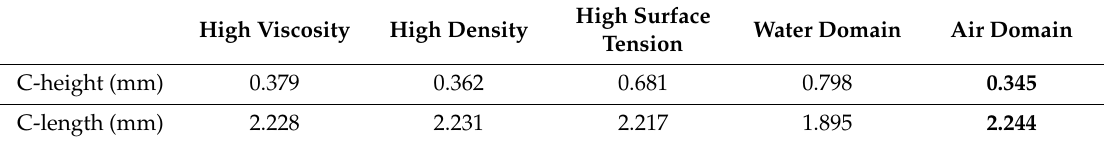
Table 4. The characteristic sizes of deformation in different material properties.